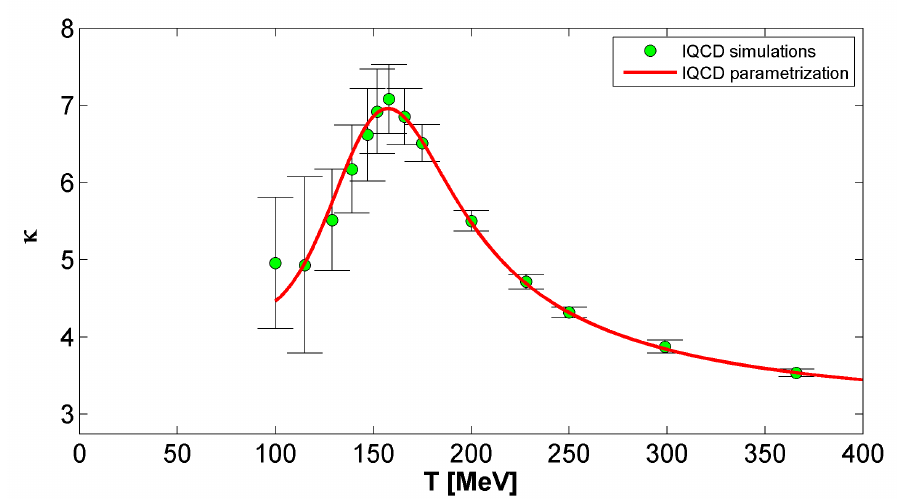
Figure 2. The result of lattice QCD simulations (green dots) on κ = ε / p measured at µ B = 0, and a phenomenological parametrization (red curve), taken from